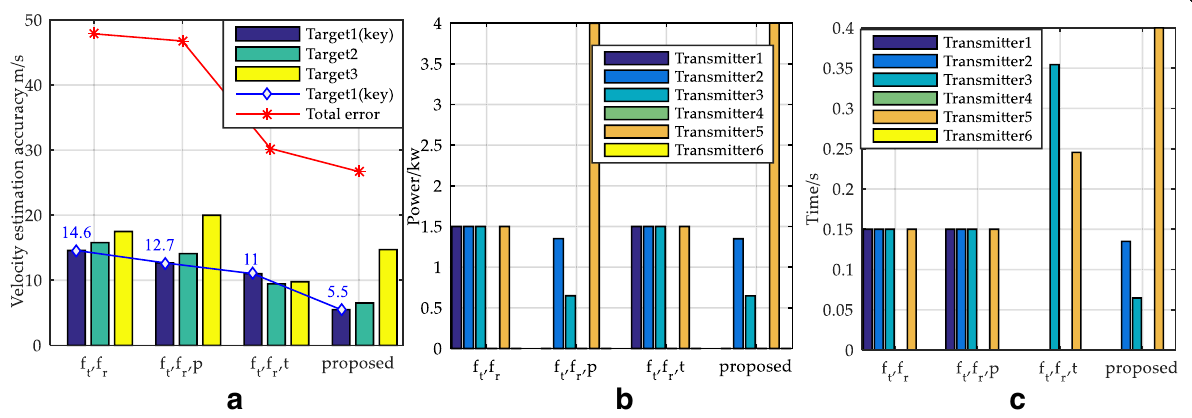
Fig. 4 Experimental results with MSE = [inf, 20 2 , 20 2 ]m 2 /s 2 . a Velocity estimation accuracy. b Power allocation results. c Time allocation results